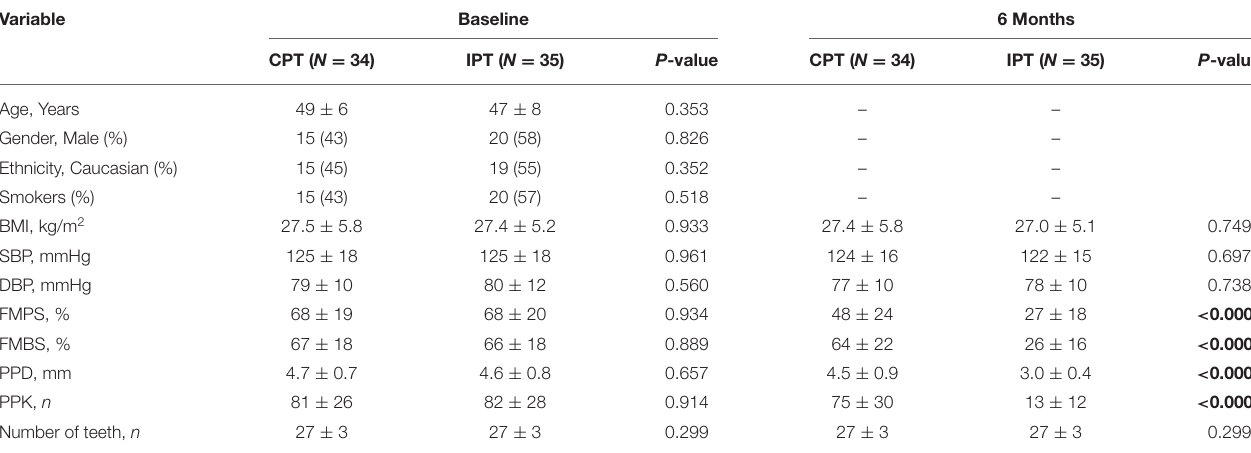
TABLE 3 | Participants’ characteristics at baseline and 6 months visits (intervention study, N = 69).